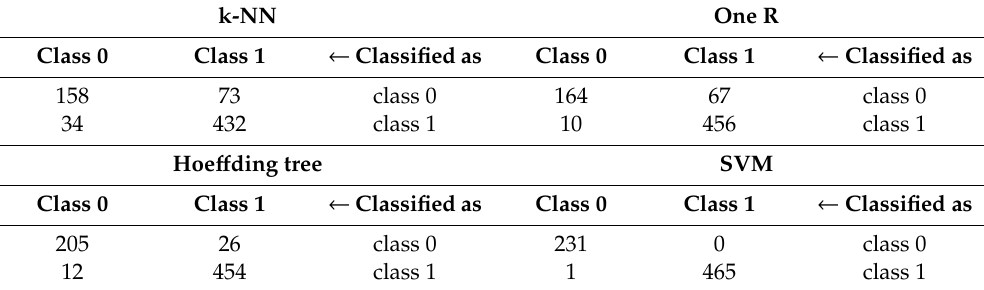
Table 4. Confusion matrixes of all the experimented classifiers.